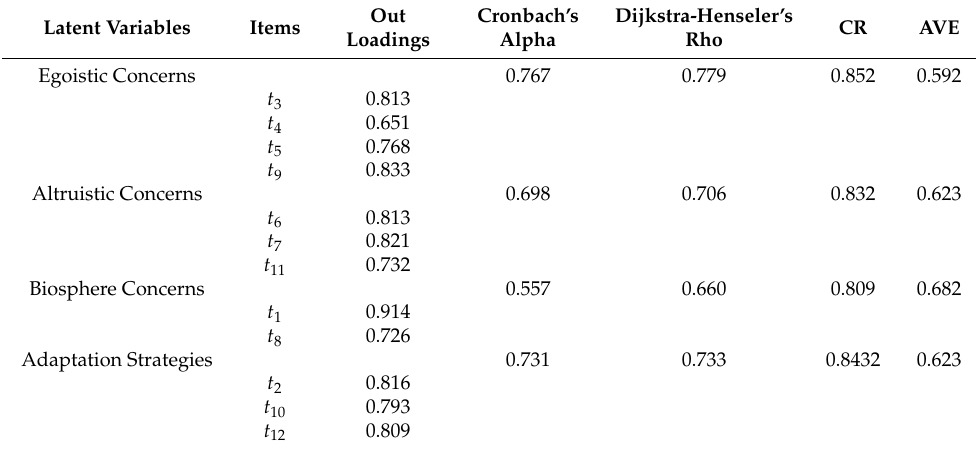
Table A1. Measurement